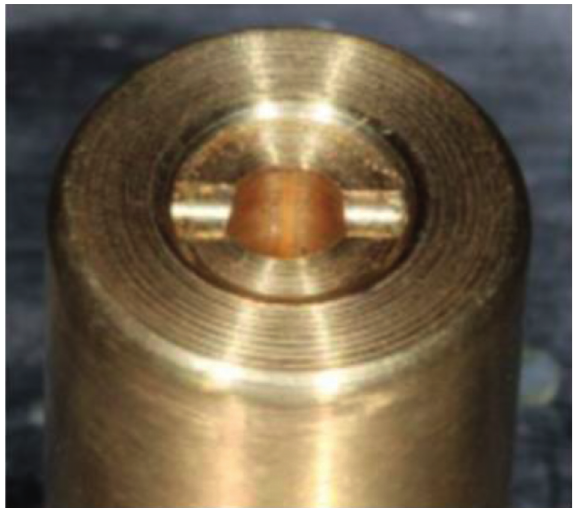
Figure 4: Stainless steel device for positioning the retaining